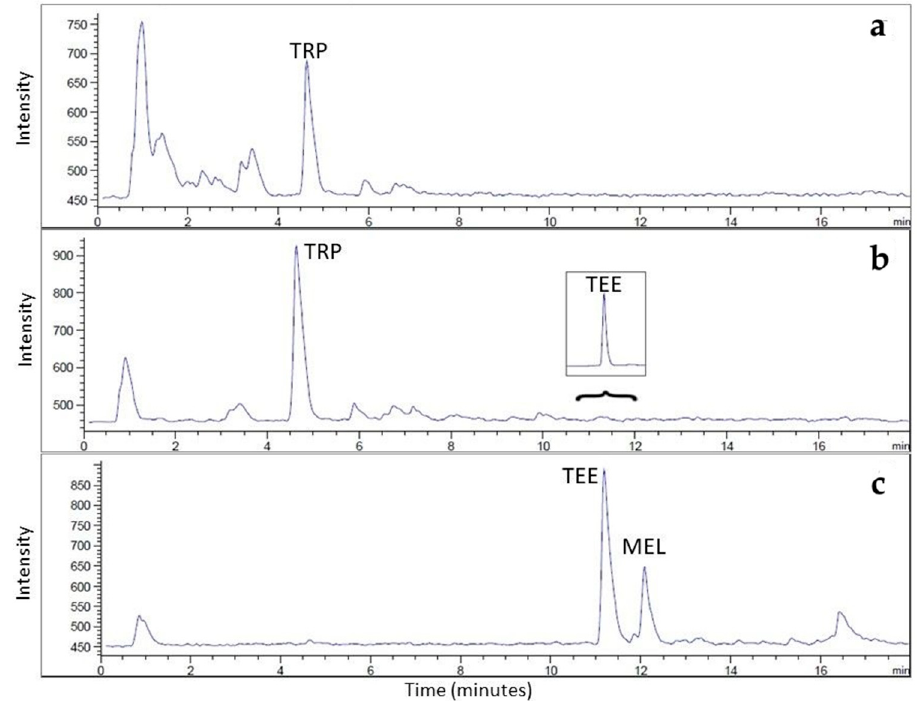
Figure 2. HPLC-MS chromatograms of ( a ) fraction A, ( b ) fraction C, and ( c ) fraction D obtained for solid phase extraction (SPE)-preconcentrated red wine sample spiked with TRP (1 mg/L), TEE (50 µ g/L), and MEL (50 µ g/L). Peak identity: TRP, tryptophan; TEE, tryptophan ethyl ester; MEL, melatonin.